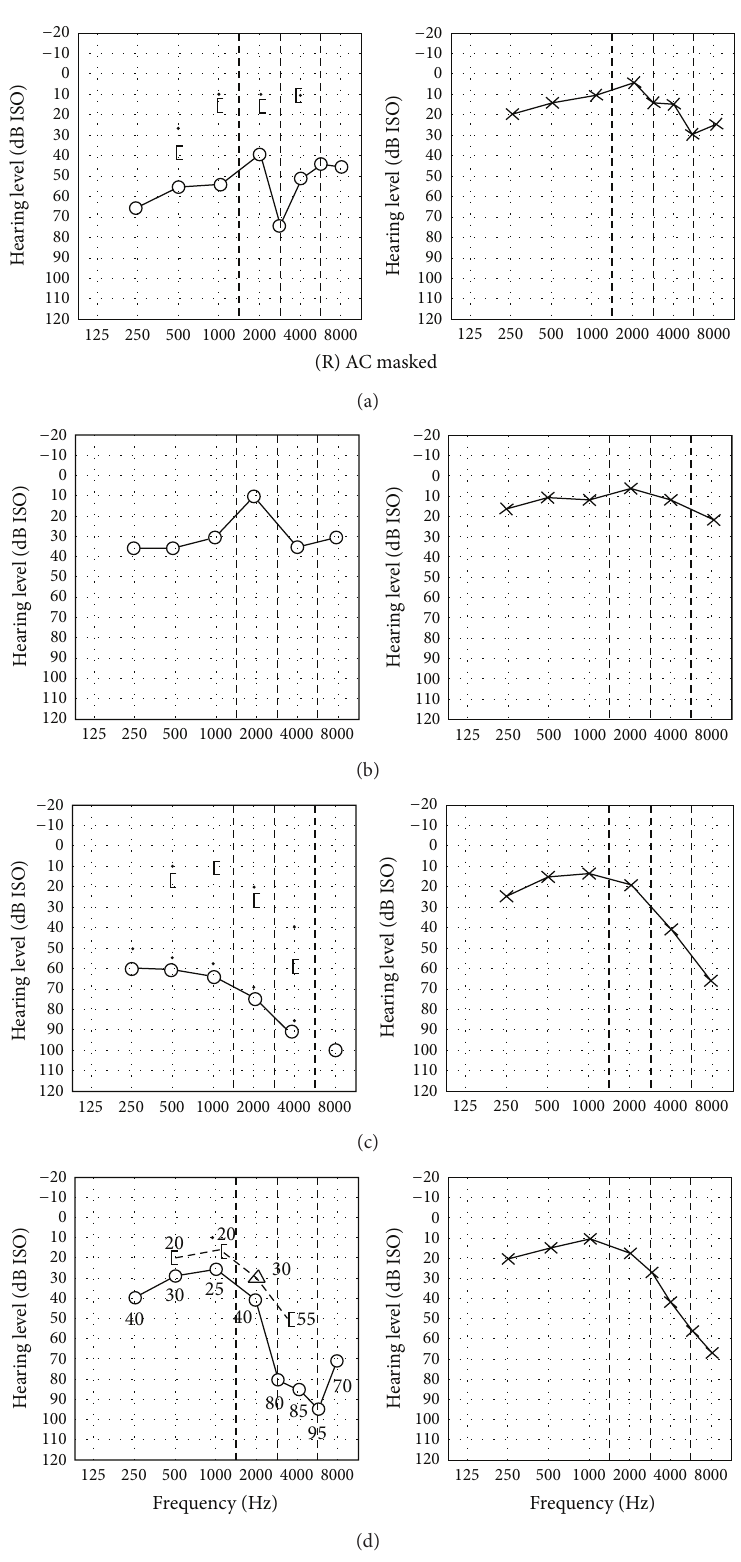
Figure 2: Representative pre- and postoperative original PTA from two patients. Two representative preoperative and postoperative PTA of two patients. Patient 1 (rows (a) and (b)) showed good closure of his operated right ear ABG from 30dB to 18 dB postoperatively. Patient 4 (rows (c) and (d)) showed excellent ABG closure over 29 dB with a residual ABG of 14dB in the operated right